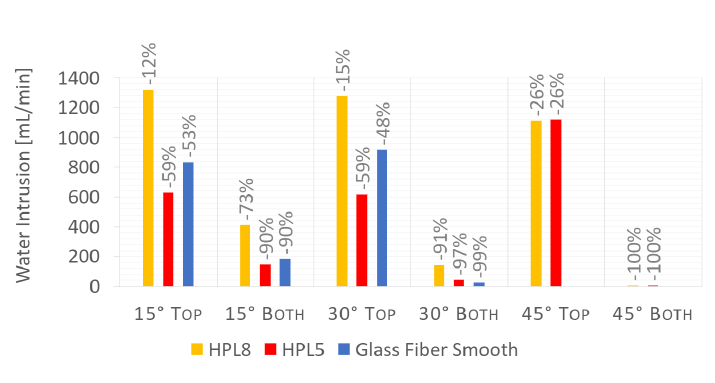
Figure 13. Water intrusion to the interior side of the HPL and Glass Fiber Smooth panels with different bevelled joint designs. HPL8 has a joint width of 8 mm, while HPL5 has a joint width of 5 mm. Bevelment degrees are 15 ◦ , 30 ◦ , and 45 ◦ . The percentage change from the water intrusion measured with the standard recommendations in Table 3 is